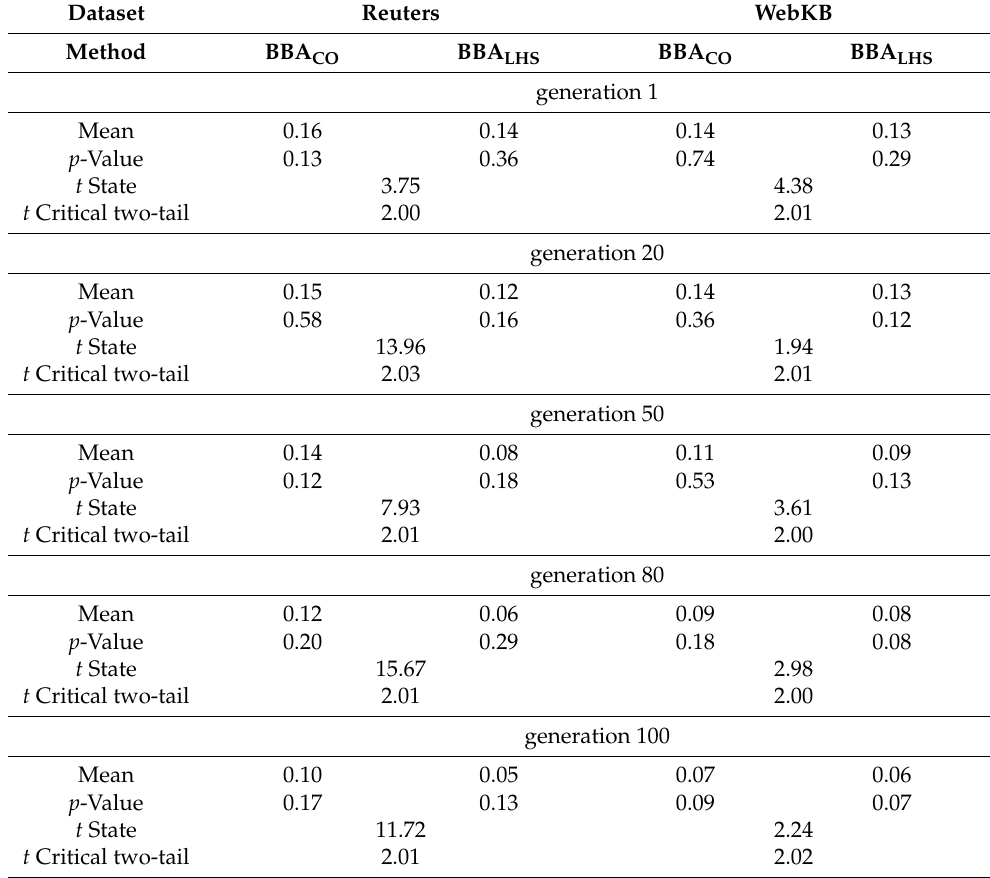
Table 3. The t -test of standard deviation of population in different generations using BBA CO and BBA LHS